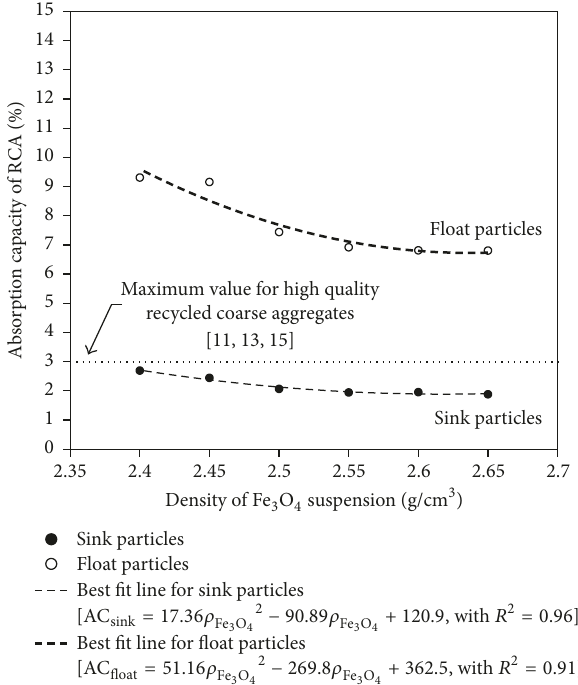
Figure 8: The variations of the absorption capacity of sink and float in the heavy medium separation process with a density of Fe 3 O 4 suspension in the drum separator.